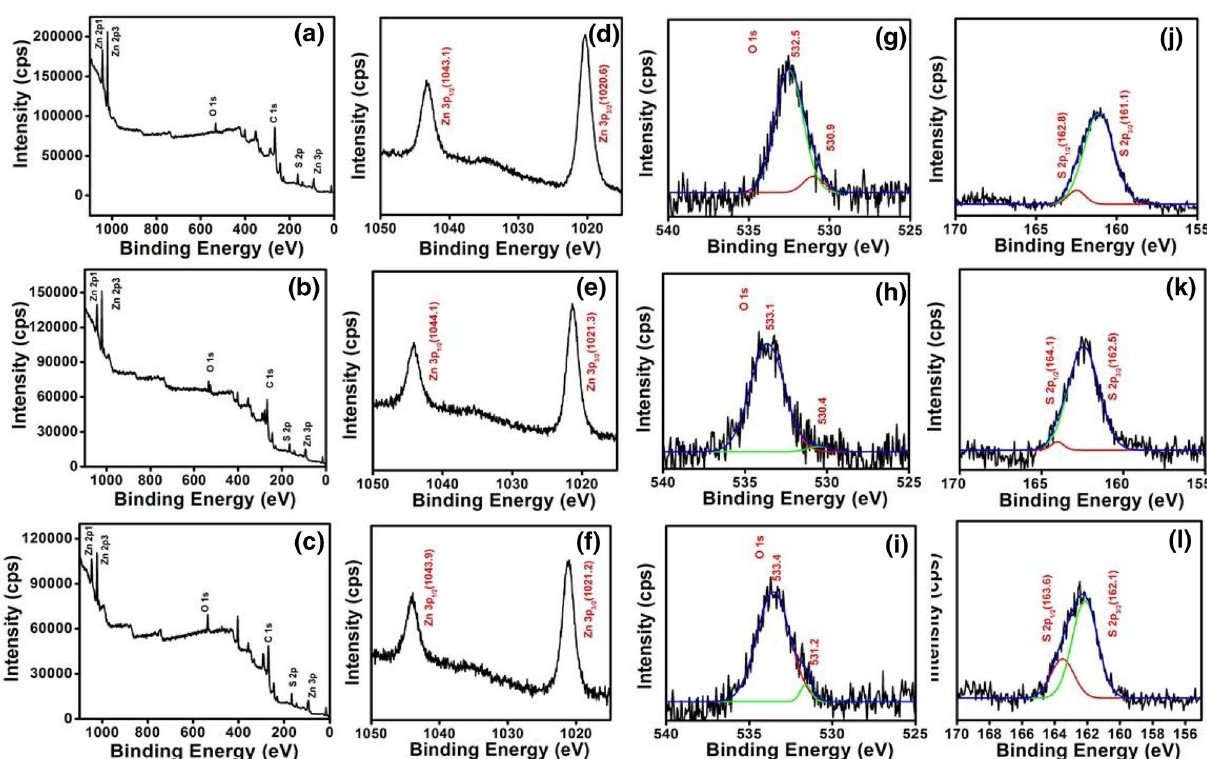
Fig. 4 a-c Fully scanned XPS spectra, high-resolution XPS spectrum of d-f Zn 2p, g-i O 1 s and j-l S 2p of Z3, Z4 and Z5 heterostructures